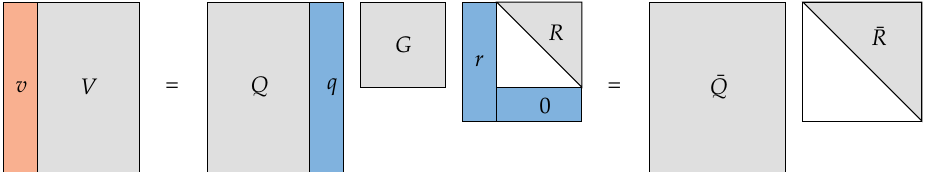
Figure 2. QR-decomposition updating procedure. For every new column added to V k on the left, the QR decomposition can be updated by adding the orthogonalised version of this column as new ( rightmost ) column q in Q , adding an additional row of zeros to R and subsequently adding a new ( leftmost ) column r to R representing the respective orthogonalisation factors. To compute the final decomposition, we have to apply Given rotations (represented by the matrix G in the figure) to eliminate sub-diagonal entries in R . ¯ Q and ¯ R represent the final decomposition